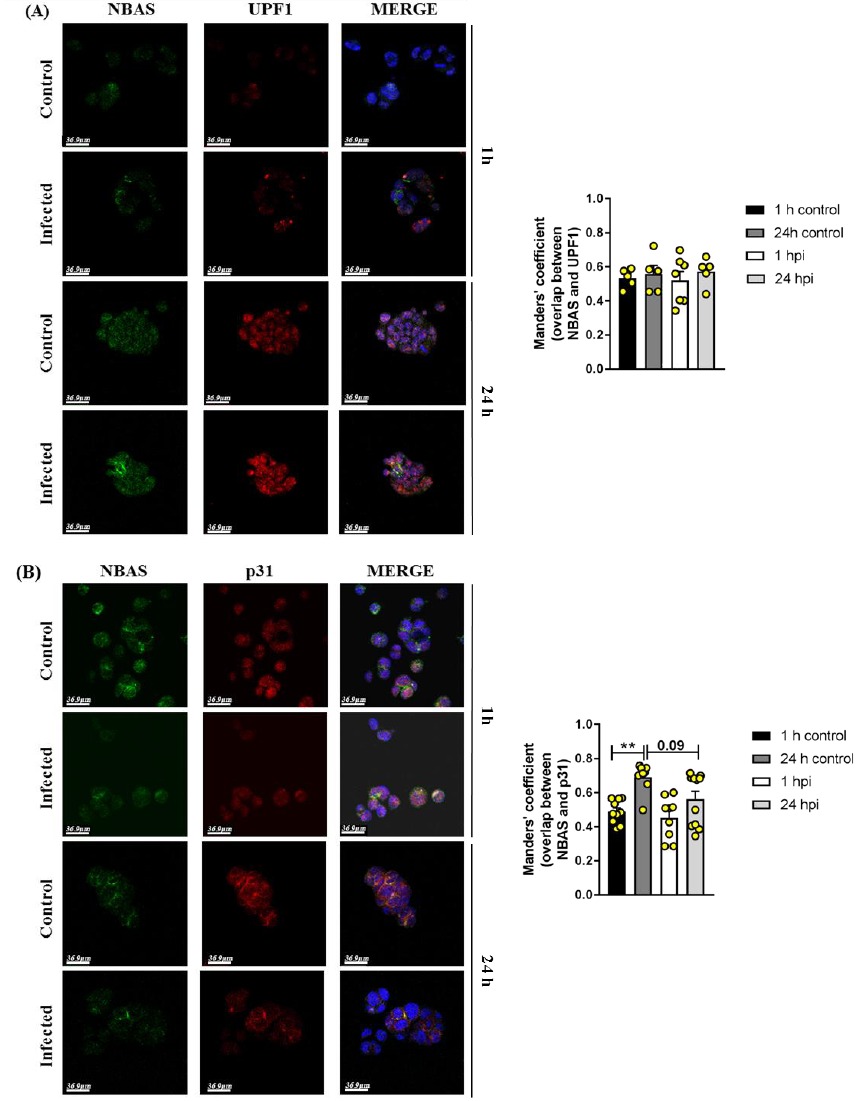
Figure 6. Representative images of immunofluorescence analysis in infected and non-infected (control) Calu3 cells stained at 1 and 24 h post-infection (hpi) for NBAS and UPF1 ( A ) and for NBAS and p31 ( B ); nuclei are shown in blue (DAPI). Scale bar: 36.9 µm. Manders ’ coefficient was calculated to quantify co-localization of NBAS and UPF1, and NBAS and p31 proteins. ** p < 0.01. One-way ANOVA with the Bonferroni multiple comparison test.